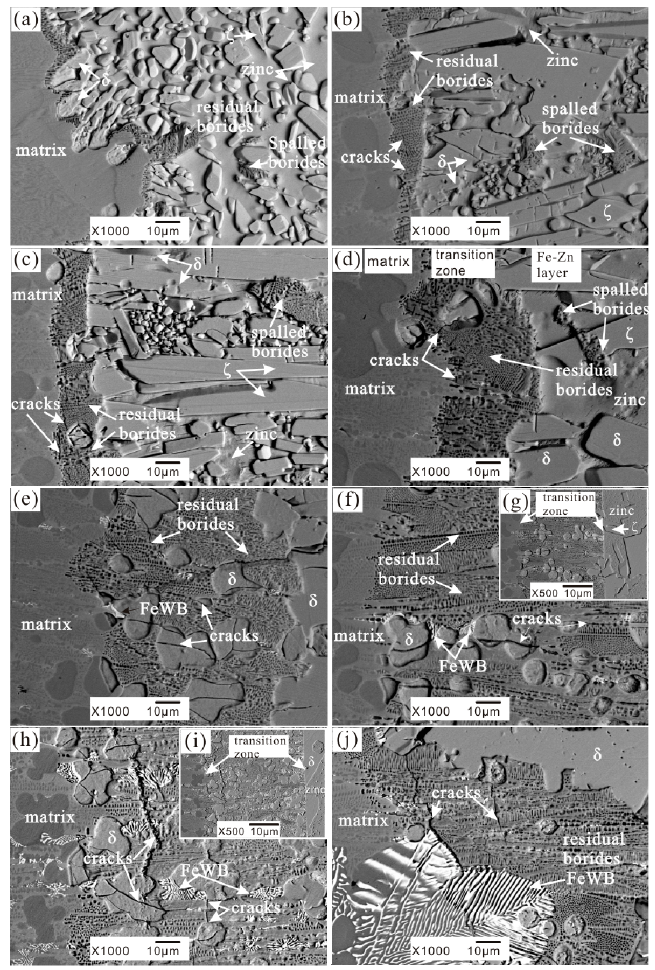
Figure 5. The morphology of corrosion layer in Fe-3.5B alloys containing different amounts of tungsten immersed in liquid zinc for 72 h at 520 °C ( a ) A0-0 wt % W ( b ) A1-2 wt % W ( c ) A2-4 wt % W ( d ) A3-6 wt % W ( e ) A4-8 wt % W ( f ) A5-11 wt % W ( g ) the transition zone of A5-11 wt % W ( h ) A6-13 wt % W ( i ) the transition zone of A6-13 wt % W ( j ) A7-15 wt % W.